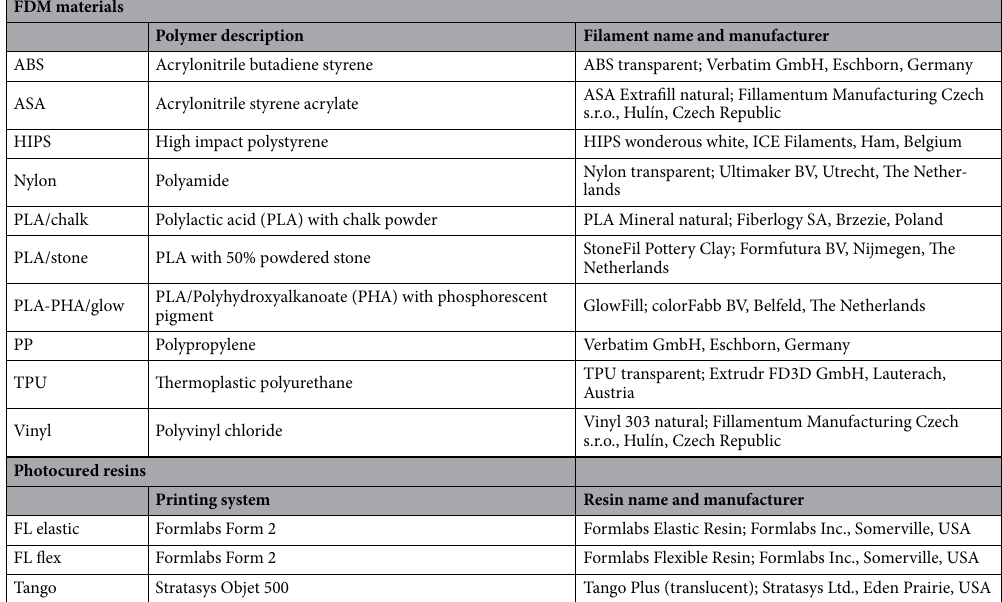
Table 4. Printing materials used. All FDM filaments were printed with an Ultimaker 2, Ultimaker BV, Utrecht, The Netherlands. Photocured resins, since manufacturer proprietary, were printing with the corresponding hardware